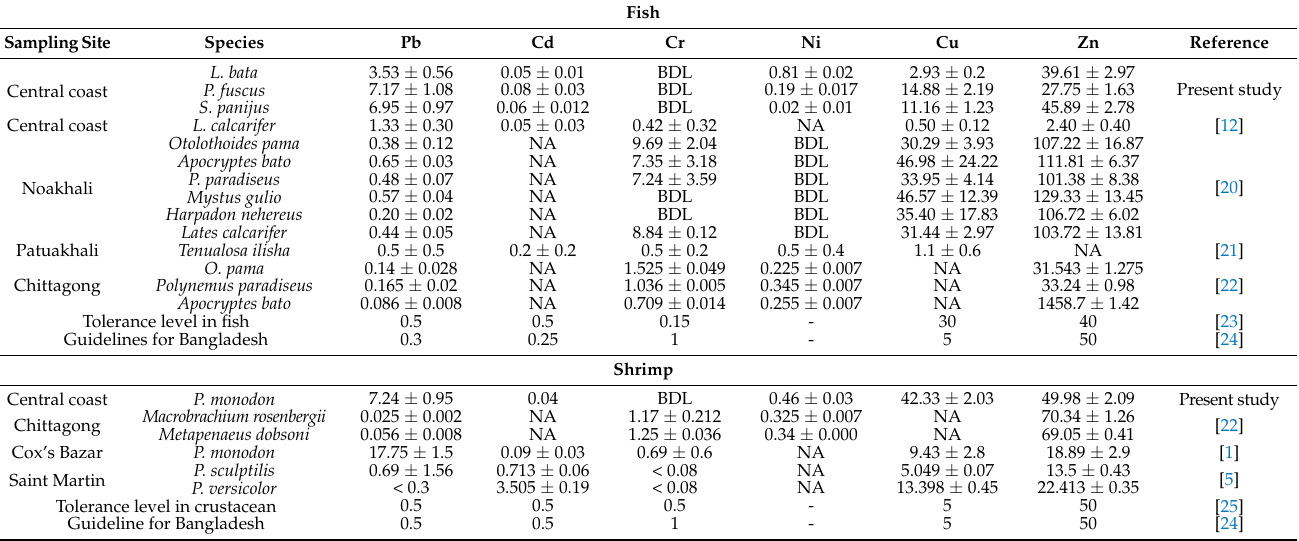
Table 2. Comparison of heavy metals (mean ± SD) in fish and shrimp muscles with various standard levels and relevant studies ( µ g/g) ( n =